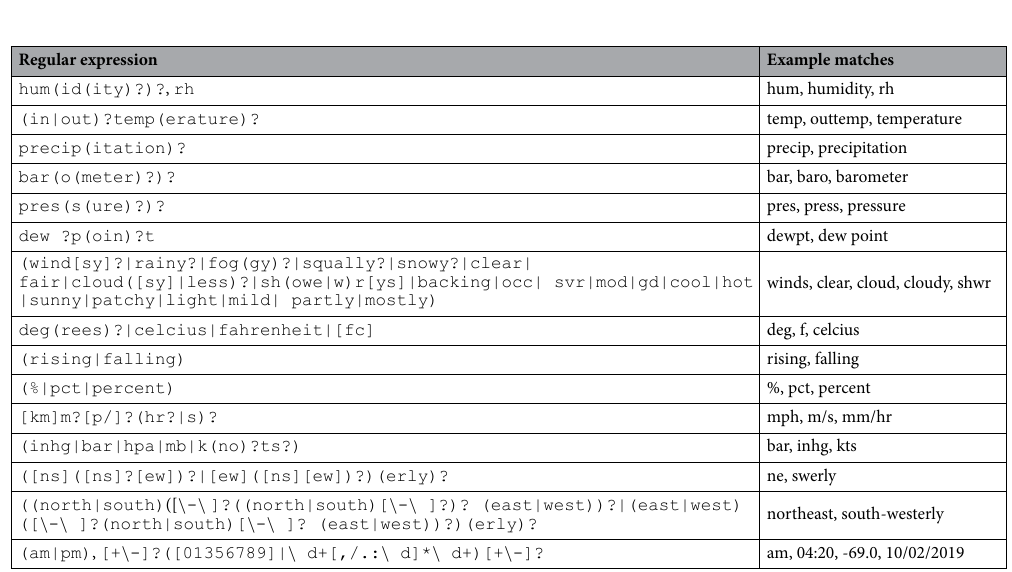
Table 1. Regular expressions used to identify tweets from ‘weather-bots’. Each regex captures key terms used to describe wind and weather, including specialised meteorological vocabulary, directions and precise scientific units. Occurrence of > 6 such tokens in a single tweet was found to be a reliable heuristic indicator that the tweet originated from a Twitter-linked amateur weather station. Tweets by weather-bots were removed from the